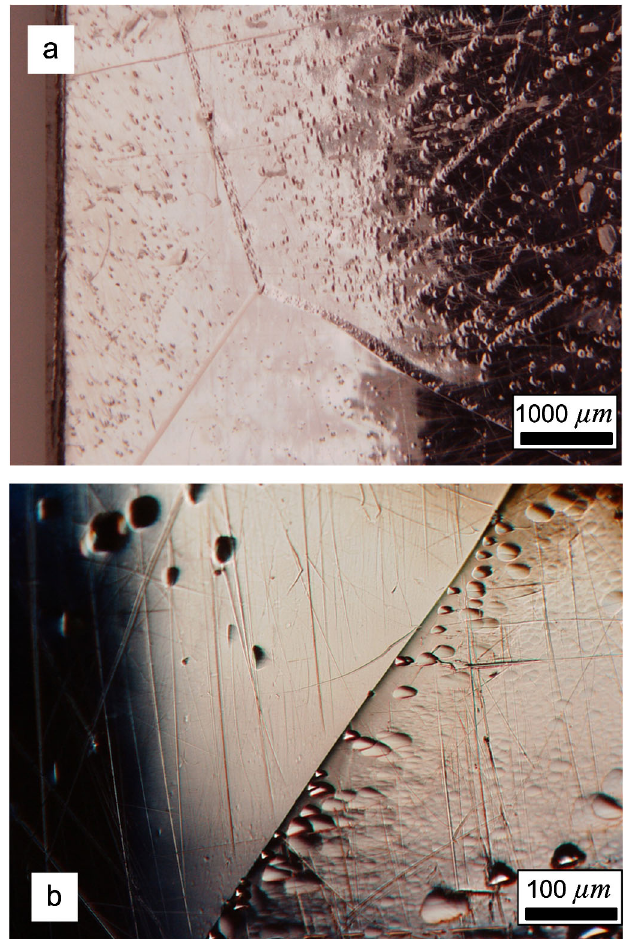
FIG. 3. Optical microscopy images of sample No. 9, showing high density of etch pits (a) and nonuniform pit distribution (b) on different crystal